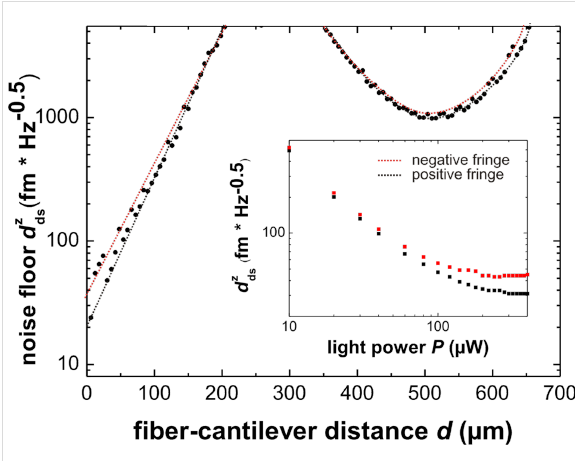
Figure 9: Displacement spectral density of the noise floor of the interferometer signal as a function of the fiber–cantilever distance d for P = 400 μ W measured for cantilever 3. The inset shows the noise floor for positive and negative fringes at d = 18 μ m as a function of the light power P